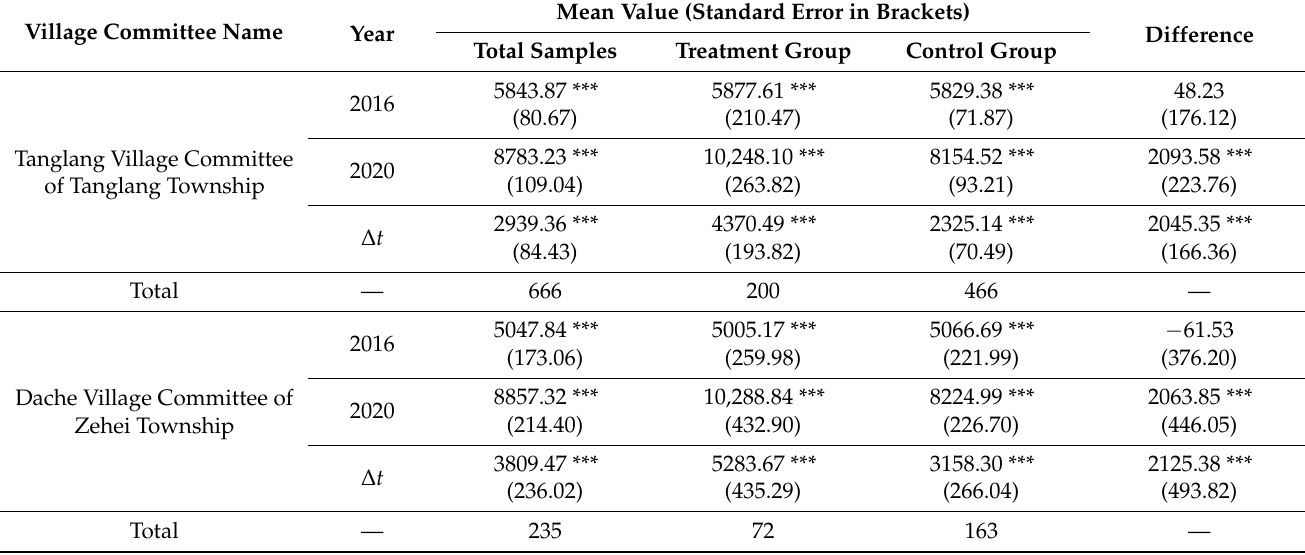
Table 6. Statistical Description of Household per Capita Net